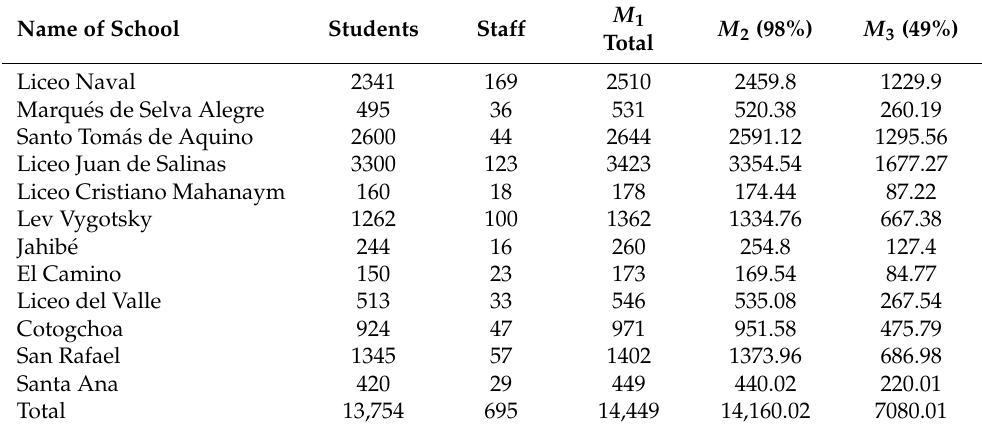
Table 14. Distribution of students, teachers, and administrative staff, and parameter values M 1 to M 3 for each